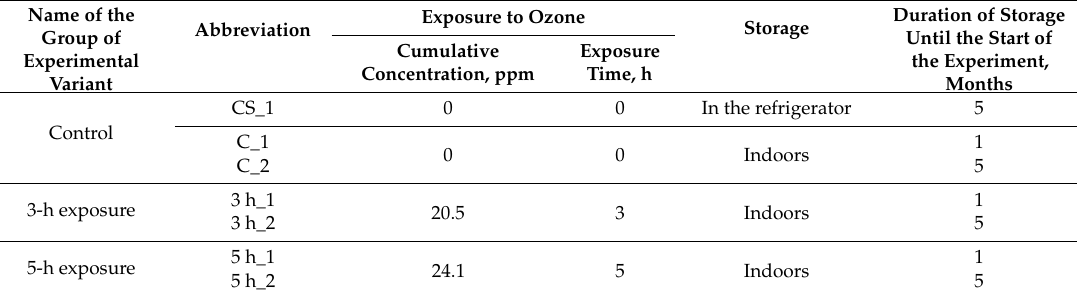
Table 2. Groups of experimental variants of